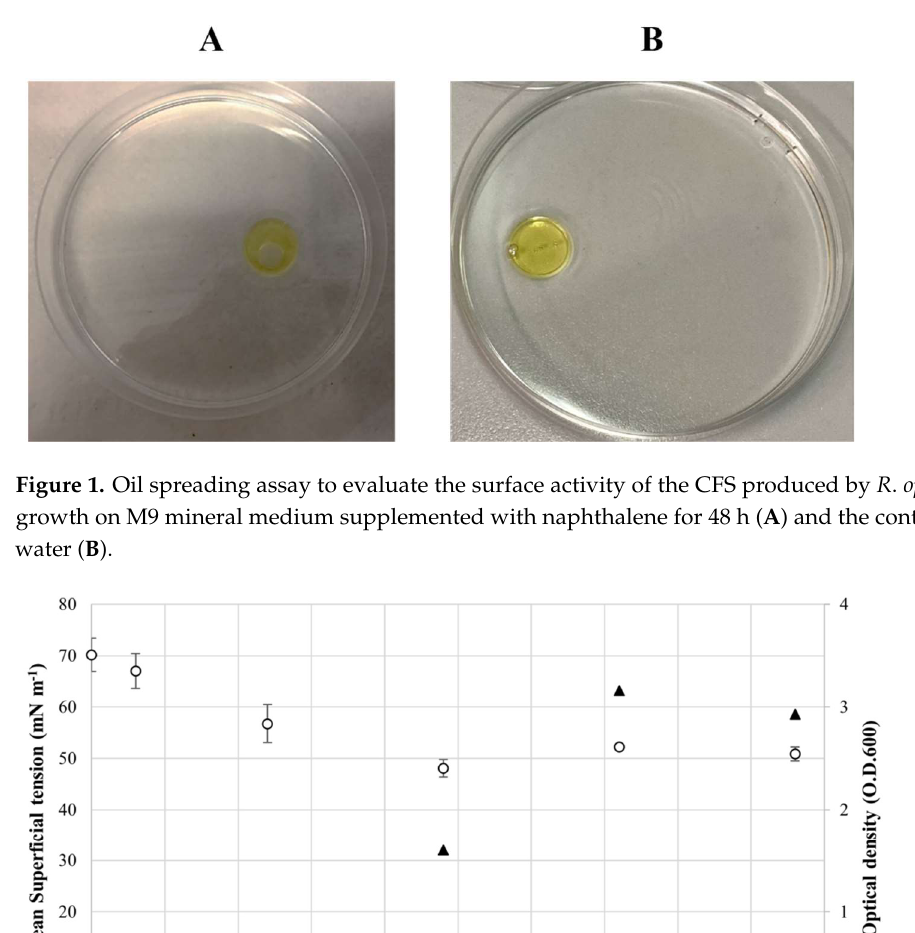
Figure 1. Oil spreading assay to evaluate the surface activity of the CFS produced by R . opacus R7 growth on M9 mineral medium supplemented with naphthalene for 48 h ( A ) and the control with water ( B ).